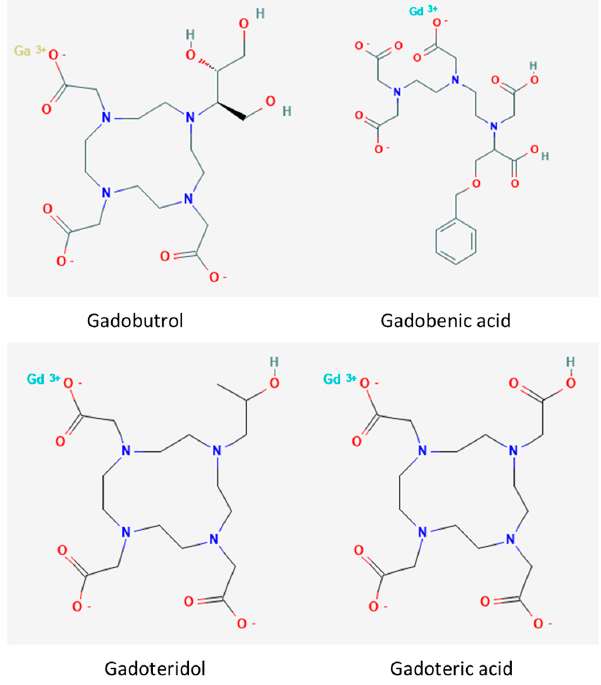
Figure 2. Gadolinium − based contrast